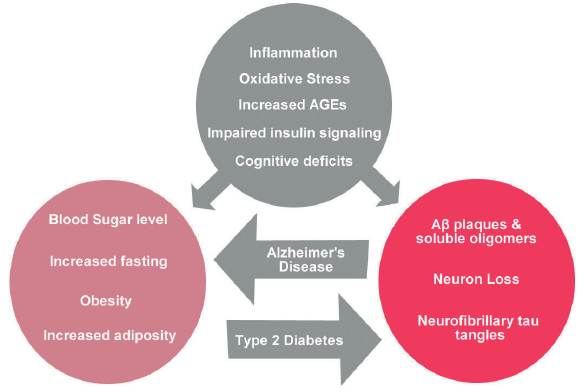
Figure 3. Distinct and shared symptoms of Type 2 Diabetes and Al- zheimer's disease. Metabolic changes that occur in type 2 diabetes mellitus, such as hyperglycemia and obesity, can induce the presence of A β plaques, hyperphosphorylated Tau protein and loss of neurons. A β plaques can induce insulin resistance. The pathophysiology of both pathologies includes inflammation, increased oxidative stress, cognitive deficit and insulin